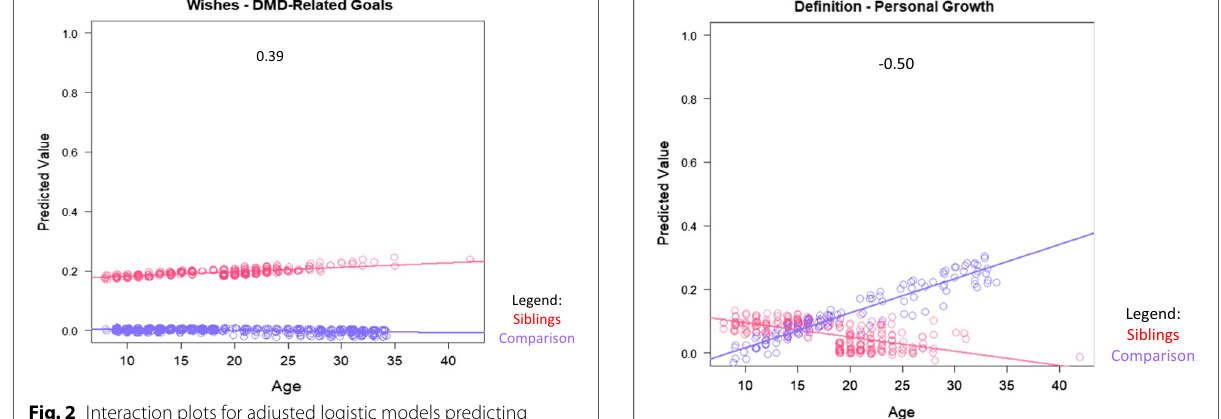
Fig. 2 Interaction plots for adjusted logistic models predicting wishes themes. Role-group differences for medium- and large-ES interaction effects are shown. Sibling predicted values are shown in red; comparison in blue